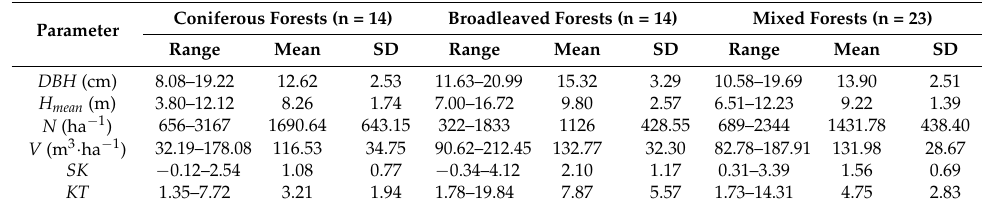
Table 1. Summary of field measured plot-level forest structure parameters and the skewness and kurtosis of field reference tree volume distribution